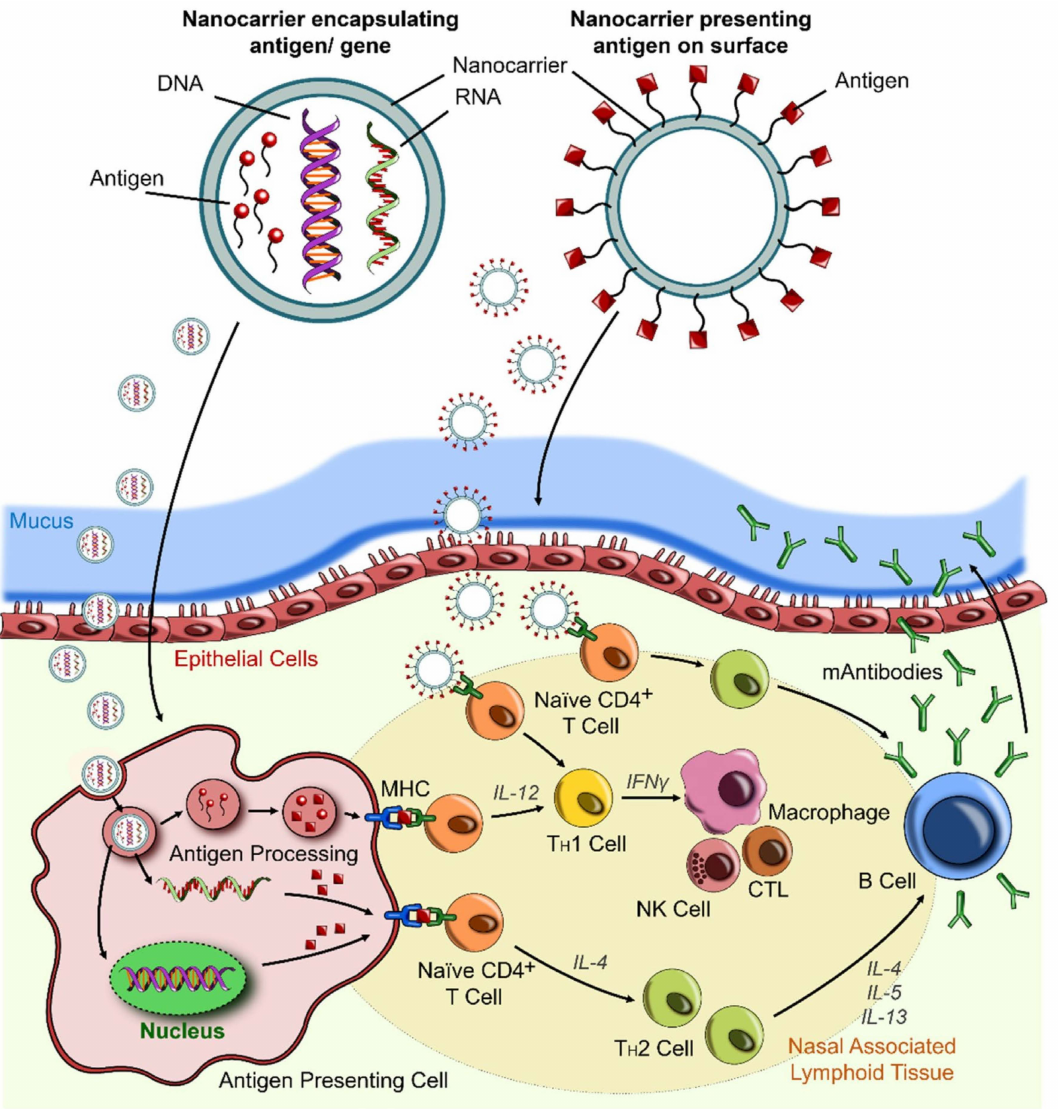
Figure 6. Schematic of providing nano-vaccines based on loading strategy; Nanoparticle-based vaccines that encapsulate an antigen for delivery and trigger an immune. Nanoparticle-based vaccines that have an antigen embedded in their surface. Reproduced with permission from